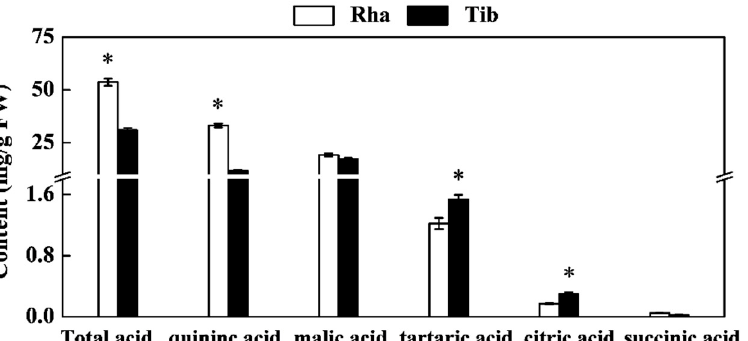
Figure 2. The content of organic acids in Rha and Tib berries. Vertical bars represent standard error of the mean ( ± SE), and the “*” indicate significant differences at p < 0.05.